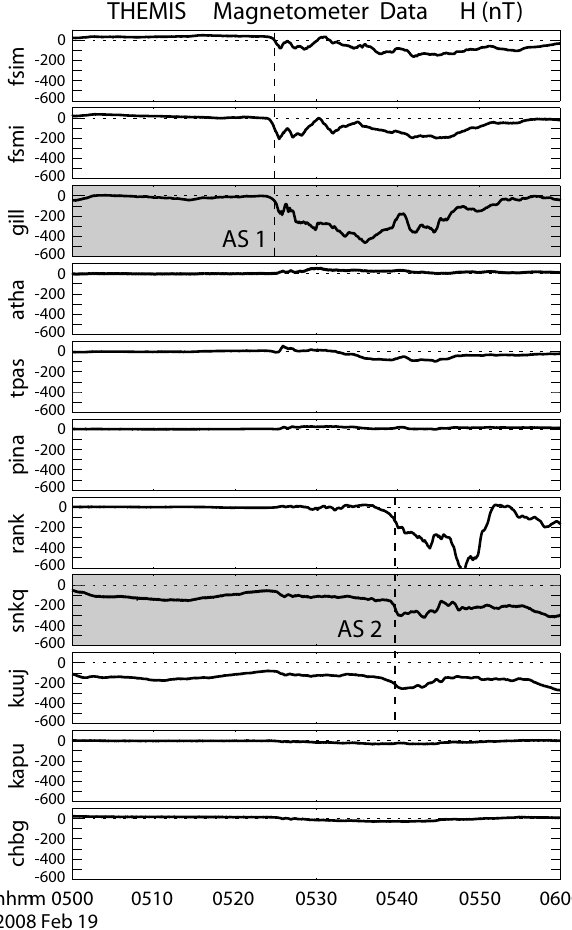
Fig. 4. Ground magnetometer data ( H component) from several THEMIS ground stations on 19 February 2008. Dashed lines mark the times of appearance of the first (AS1) and second (AS2) auroral spirals. The data in the gray shaded panels are from ground stations that recorded the auroral spirals in their ASI